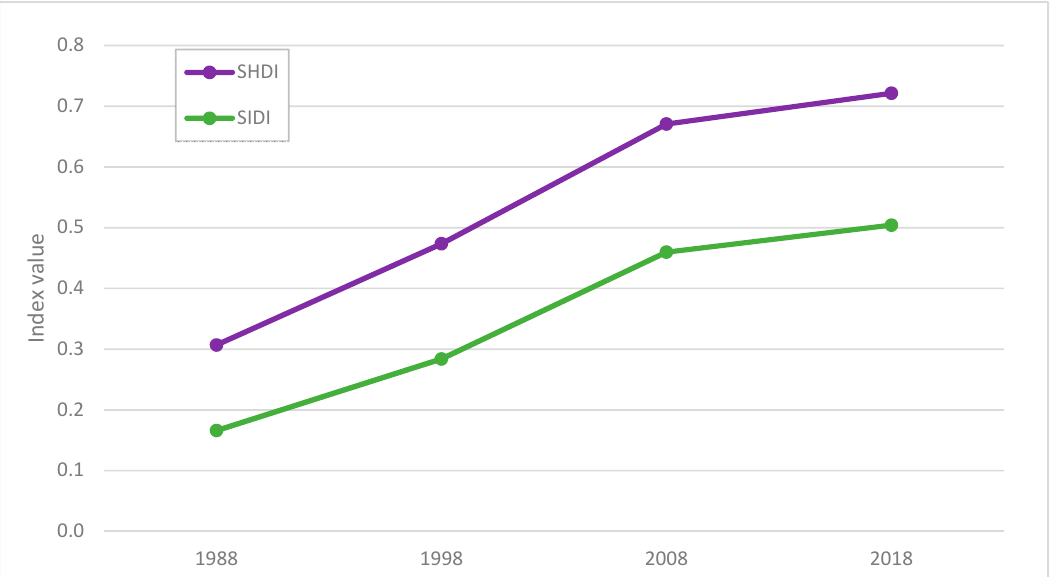
Figure 8. Evolution of landscape percentage for each land use/land cover class over time, between 1988 and 2018.